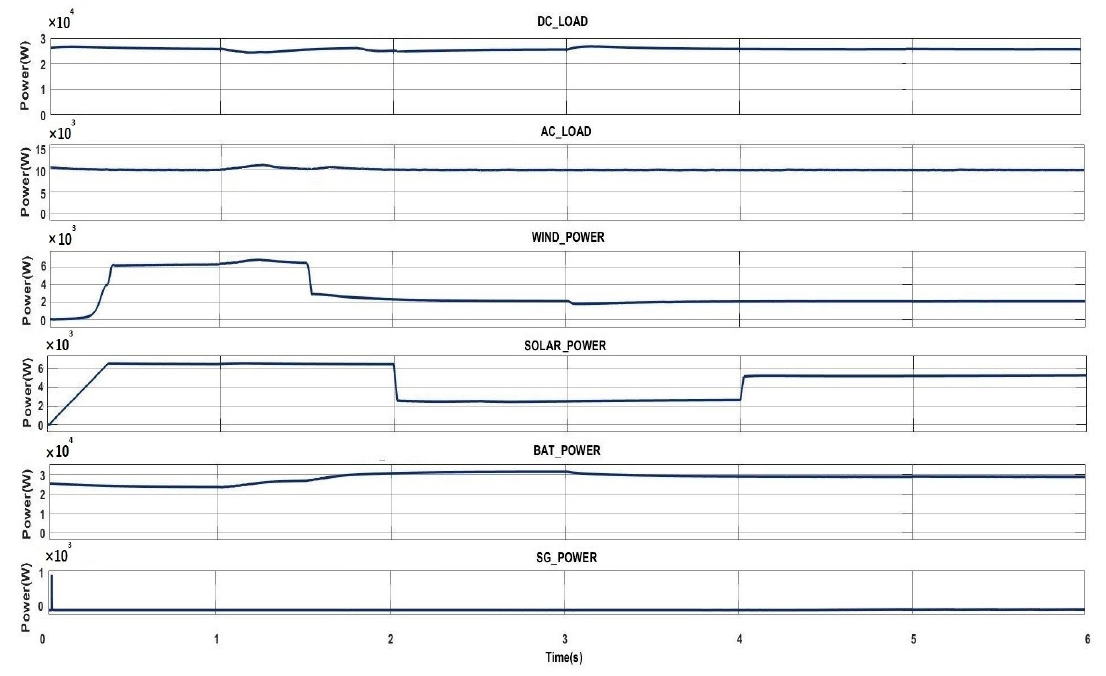
Figure 6. The variation in system components’ power level for different conditions.